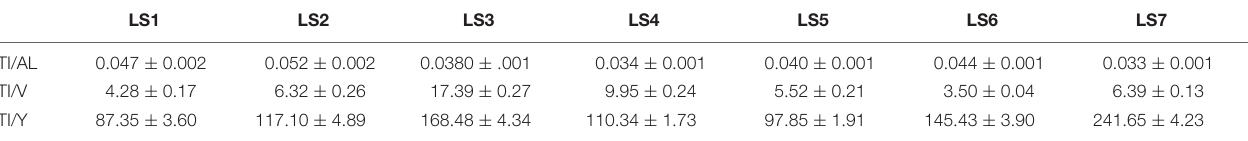
TABLE 1 | Elemental ratios of Ti over Al, V, and Y in the digested bulk